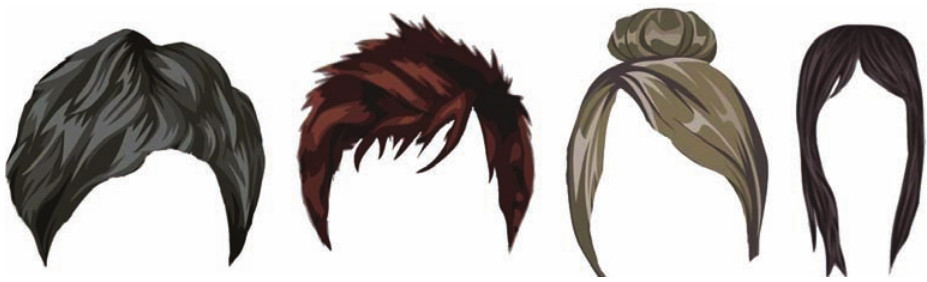
Figure 6: Cartoon hair template